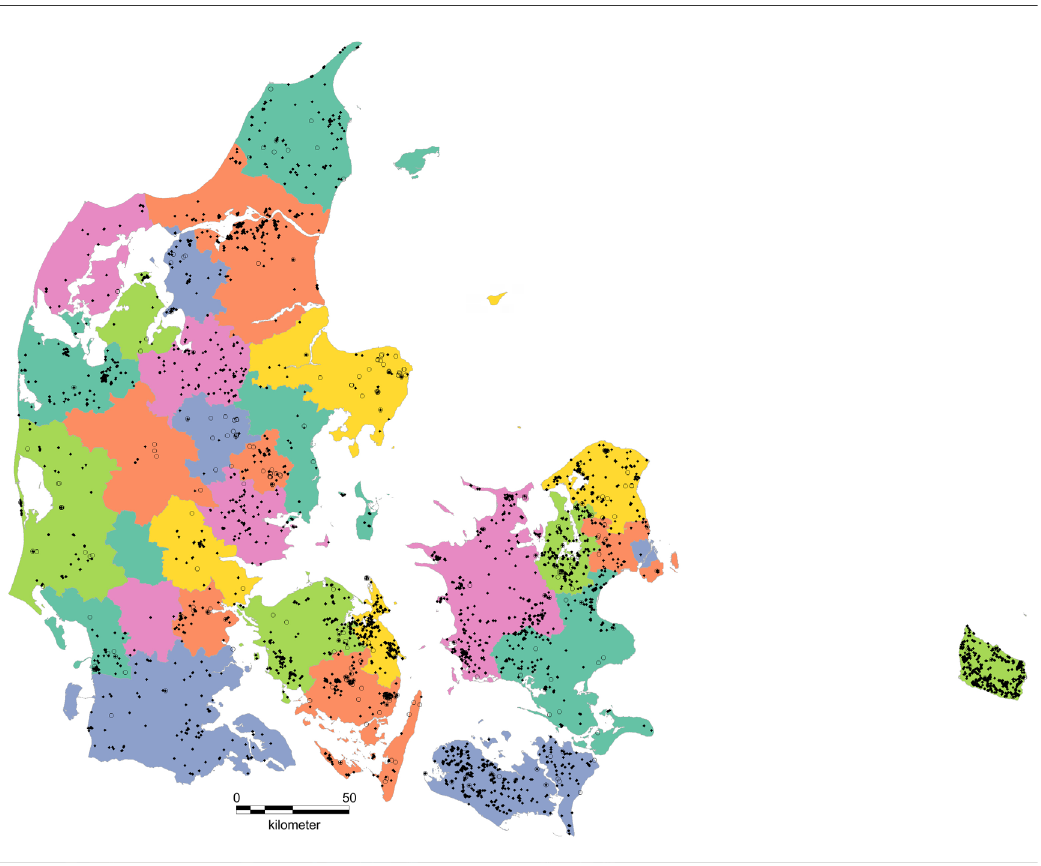
Figure 4: Distribution of findspots for treasure trove finds discovered with metal detectors in Denmark up to and including 2006. Data: Kulturstyrelsen; drawing by Mogens Bo Henriksen, Odense Bys